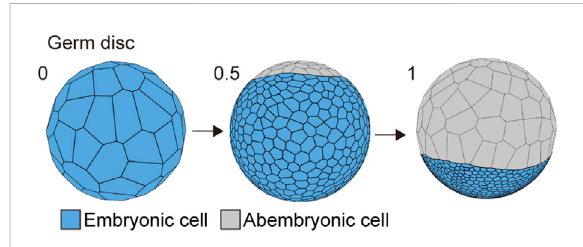
FIGURE 3 Spherical to germ disc embryo shaping in P. tepidariorum. The embryo size was 570 μ m diameter, and the cell number ranged from 64 ( t = 0) to 1,500 ( t = 1) epithelial cells. When thecell number reached approximately 1,000 cells by cell division ( t = 0.5), the cells differentiated into two typed-cell populations that were embryonic (blue) and abembryonic (gray)